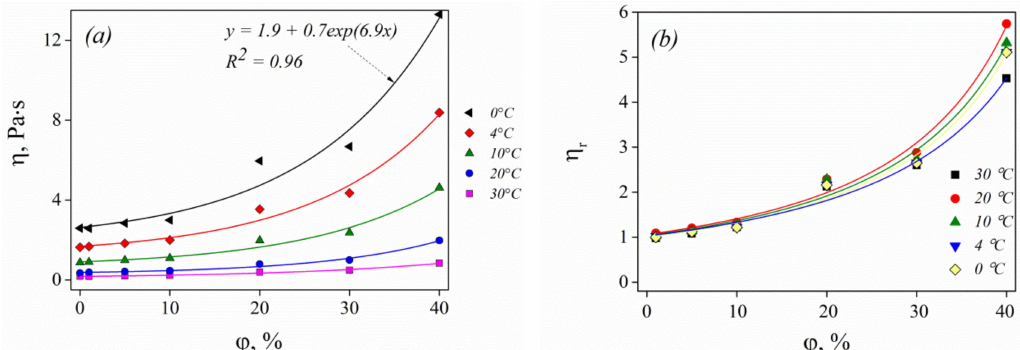
Figure 8. Viscosity ( a ) and relative viscosity ( b ) of w/o emulsions versus aqueous phase volume fraction at different temperatures. Points are experimental data. Lines are approximations by the exponential law ( a ) and the Krieger and Dougherty (KD) equation ( b ).